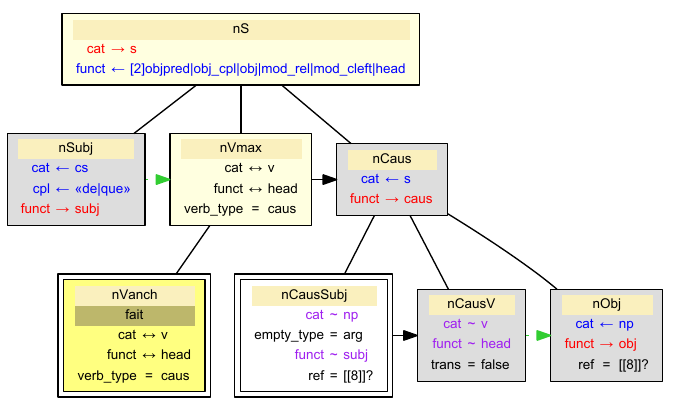
Frigram: a French Interaction Grammar